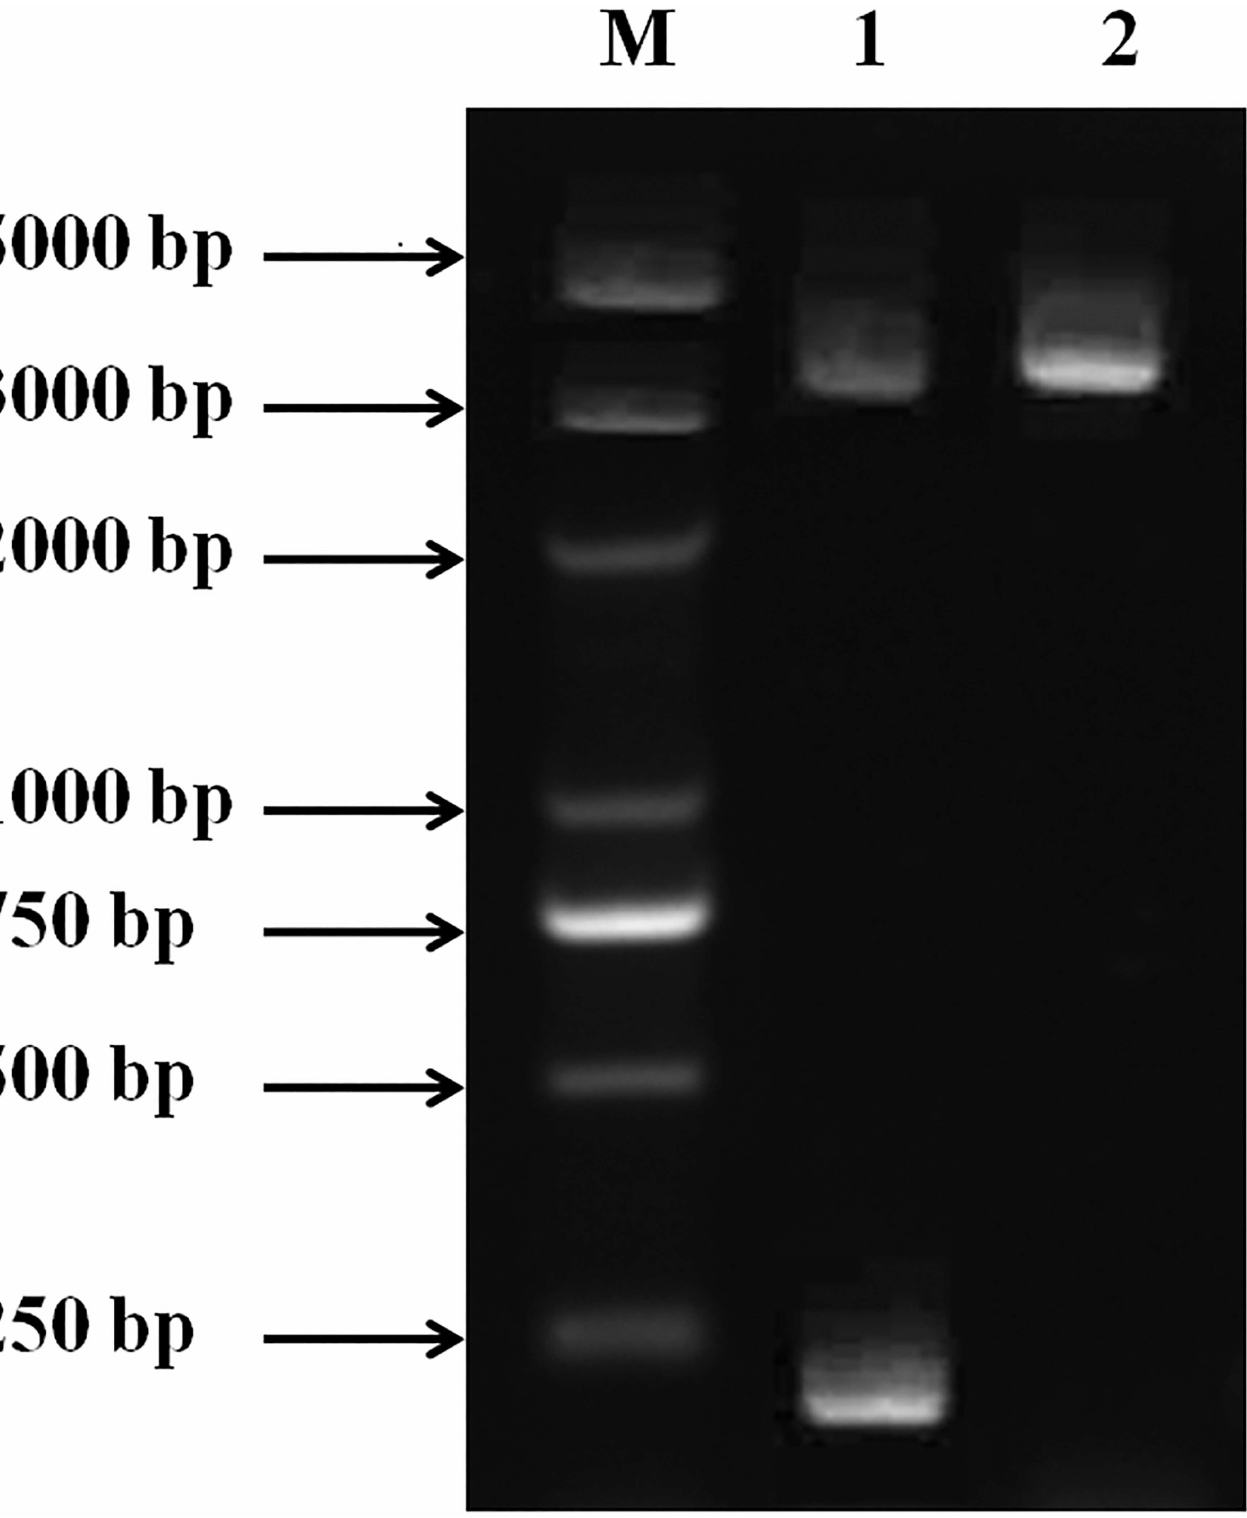
Fig 1. Identification of the recombinant plasmid phoA-MT by restriction enzyme digestion and PCR. 1. DNA marker; 2. phoA-MT digestedwith NcoI and BamHI endonucleases (Up: Phoa plasmid, Down: MT); 3. Recombinant plasmidphoA-MT.